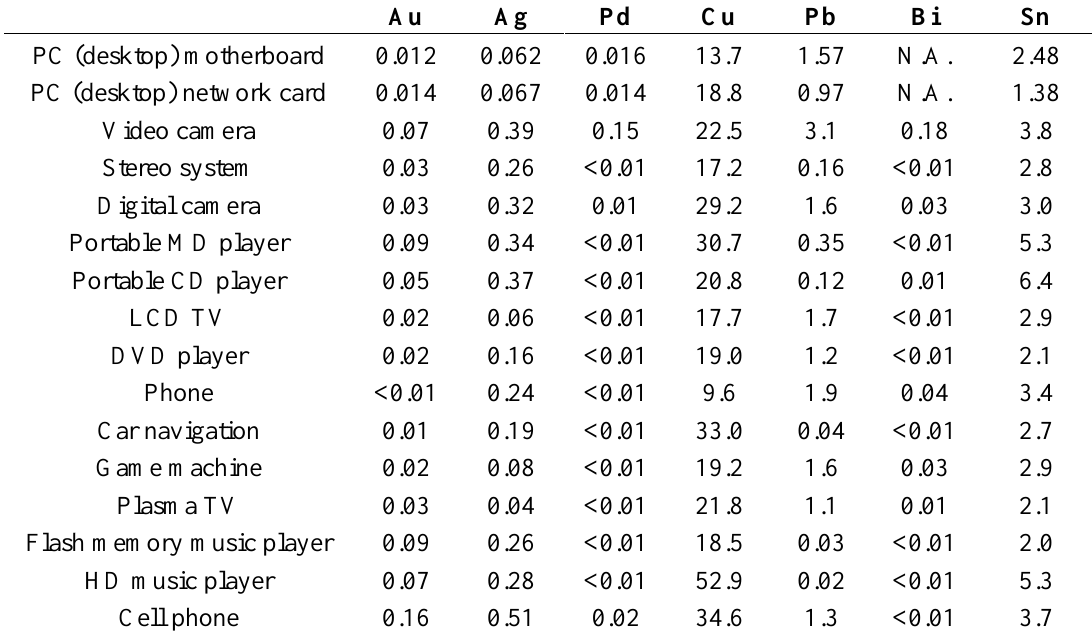
Table 3. Content by weight of precious and other metals in different types of circuit boards (Unit = %) (PC = personal computer, MD = mini-disc, CD = compact disc, LCD = liquid crystal display, HD = hard